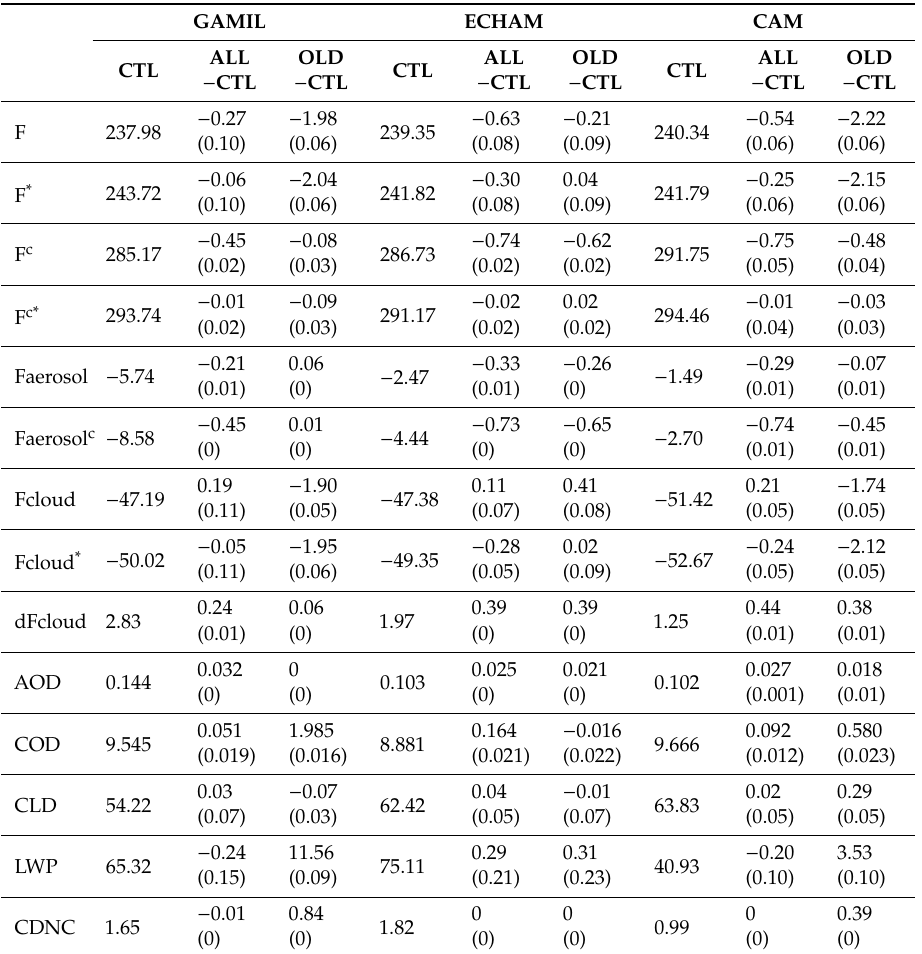
Table 3. Ensemble averages of global annual mean results from the CTL, ALL, and OLD experiments. The details on these variables are listed in Table 2. Standard deviations (in brackets) are calculated from the di ff erent ensemble